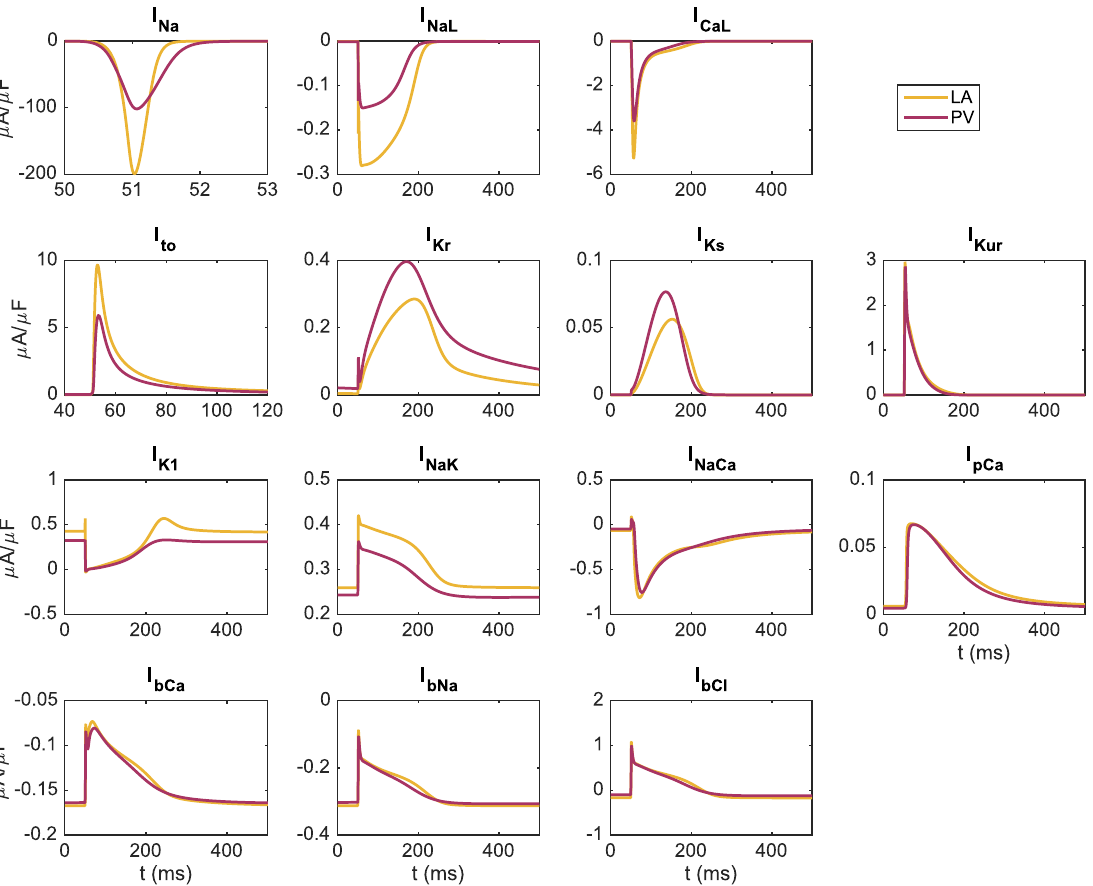
Figure 3. Membrane currents during an action potential in the LA and PV versions of the base model. Definitions and mathematical specifications for each of these currents are provided in the Supplementary Information.